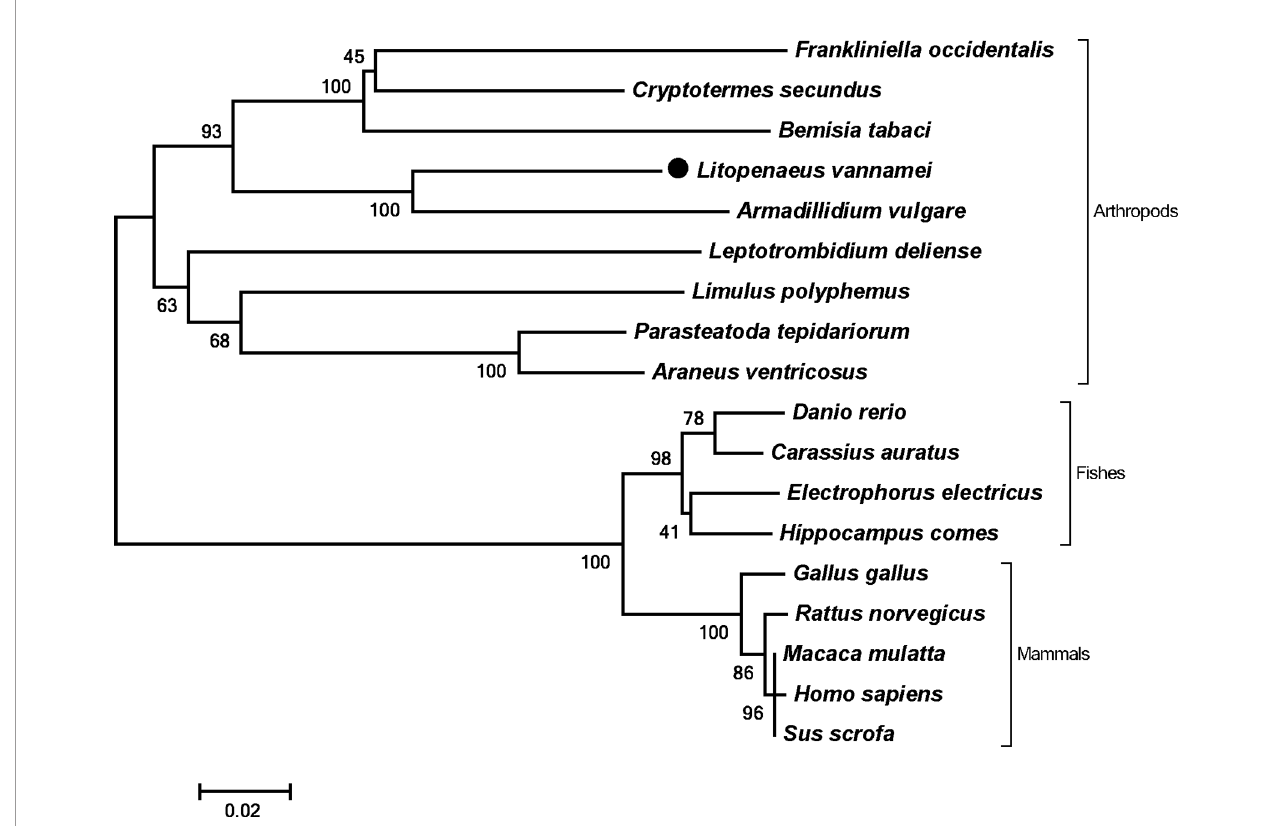
FIGURE 2 | Phylogenetic tree of PTPN6s. Amino acid sequences of PTPN6s were obtained from NCBI with GenBank accession numbers of Frankliniella occidentalis (XP_026279043.1), Cryptotermes secundus (XP_023713602.1), Bemisia tabaci (XP_018912318.1), Armadillidium vulgare (RXG72814.1), Leptotrombidium deliense (RWS28580.1), Limulus polyphemus (XP_022245683.1), Parasteatoda tepidariorum (XP_015930014.1), Araneus ventricosus (GBM95823.1), Danio rerio (NP_956140.1), Carassius auratus (XP_026121403.1), Electrophorus electricus (XP_026888060.1), Hippocampus comes (XP_019712005.1), Gallus gallus (NP_990299.1), Rattus norvegicus (NP_001171064.1), Macaca mulatta (NP_001248038.1), Homo sapiens (NP_002822), and Sus scrofa